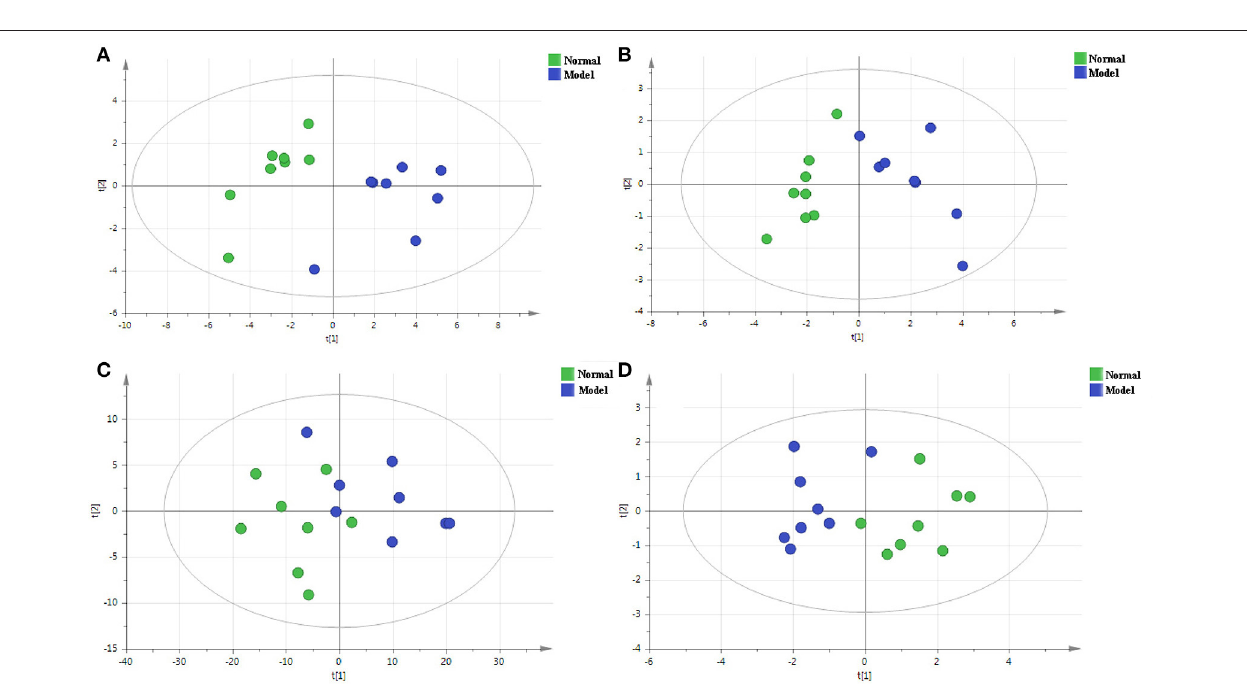
FIGURE 4 | The PCA score plots of the normal group and the model group in the positive mode of the non-polar part (A) and the positive mode of the polar part (B) of the serum, and in the positive mode of the non-polar part (C) and the positive mode of polar part (D) of the cerebral